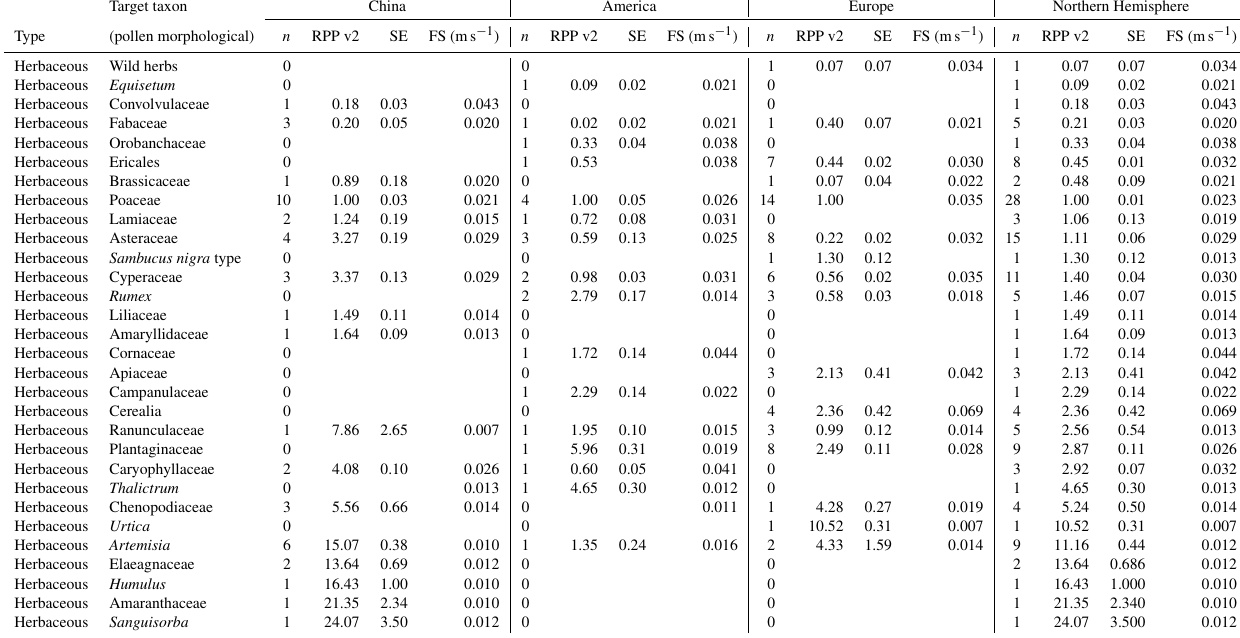
Table 6. Overview of continental and northern hemispheric relative pollen productivity (RPP) values for herbaceous vegetation with their standard error (SE) (dataset v2) and fall speeds. All values are relative to Poaceae. See Table A1 for information on original RPP data, Table A4 for information on original fall speed values, and methods on the creation of dataset v2 (Wieczorek and Herzschuh, 2020, https: //doi.org/10.1594/PANGAEA.922661). The group of wild herbs is taken from the publication of Matthias et al.